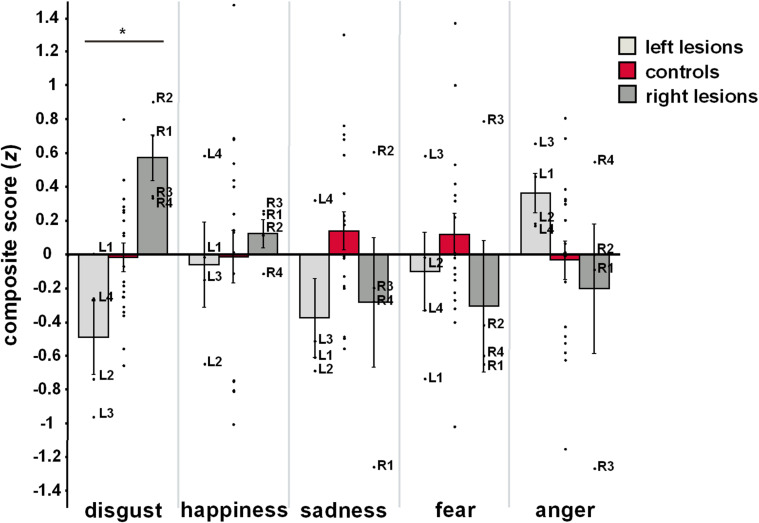
Mean and individual emotion-specific composite scores for each group. Error bars represent standard error of the mean. *P < 0.05, one-way ANOVA for main group effects. Left-lesioned patients: L1-4, right-lesioned patients: R1-4.